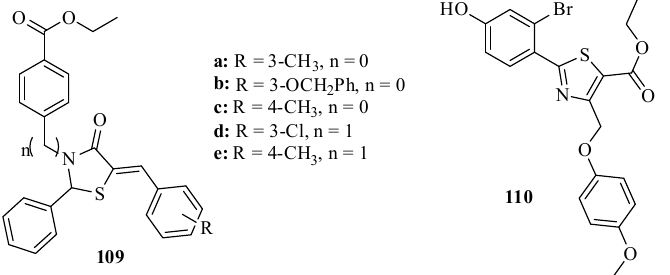
Figure 45. Structures of 4-thiazolinone ( 109a – e ) and ethyl 4-(substituted phenoxymethyl) thiazole-5-carboxylate derivatives ( 110 ).